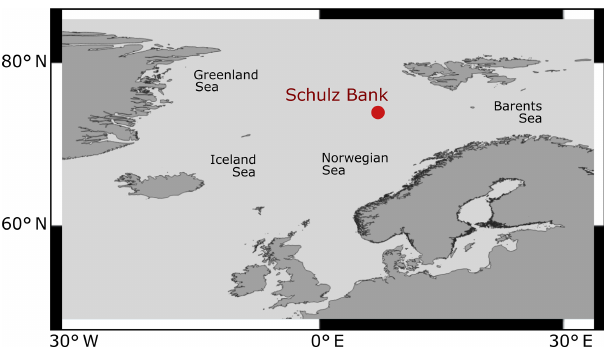
Figure 1. Overview map showing the location of the Schulz Bank seamount between the Greenland and Norwegian